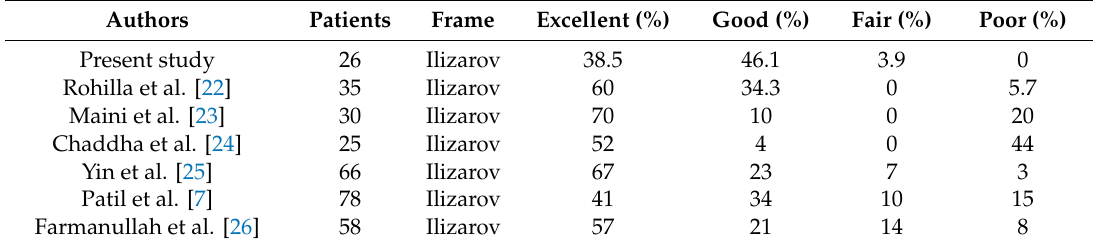
Table 7. Comparison between the results of the di ff erent studies using the ASAMI Bone Scoring System.